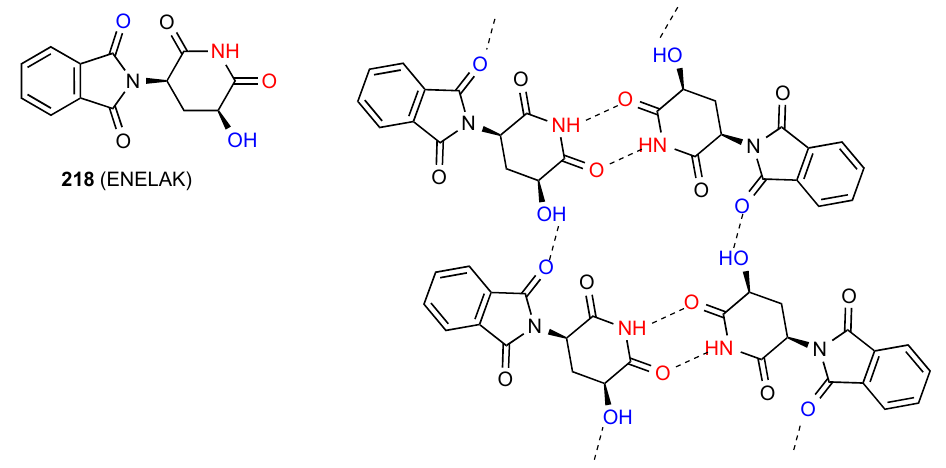
Figure 66. Structure adopted by compound 218.